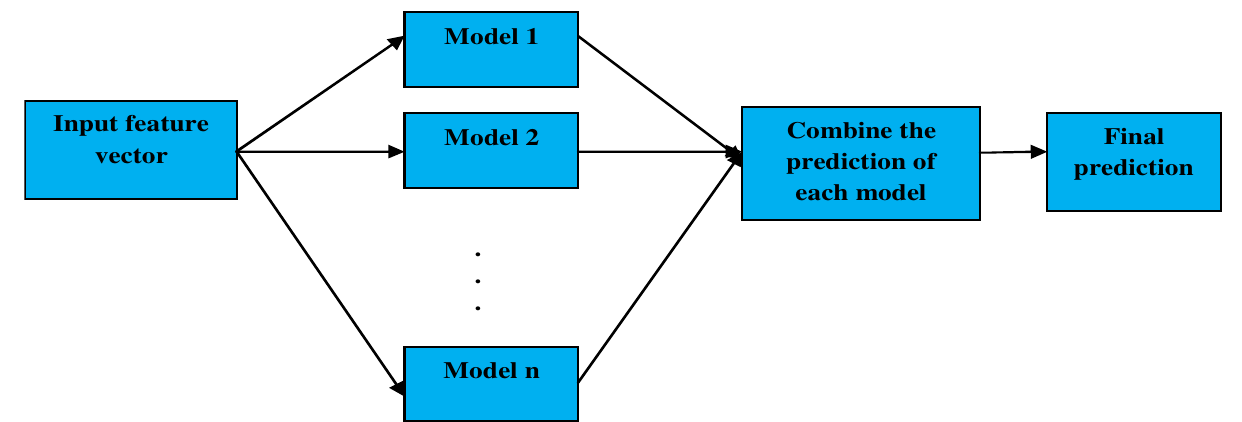
Figure 5. The architecture of the AdaBoost classifier.